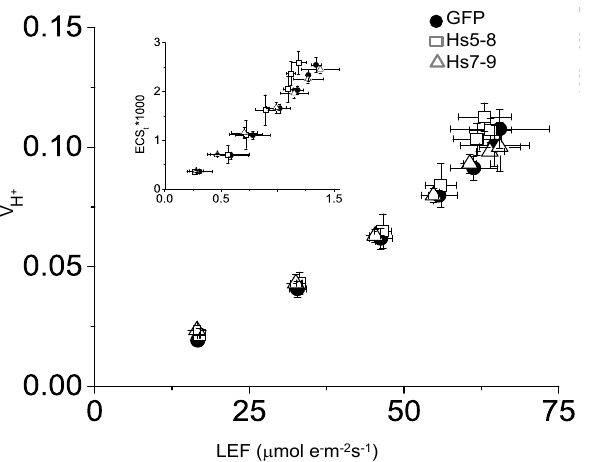
Figure 11. CEF is not increased in Hs PIPKIα plants. Light-driven transthylakoid proton flux ( v H+ ) as a function of linear electron flow (LEF) rates and relative light induced pmf , as measured by the total amplitude of the ECS decay (ECS ), as a function of pmf t attributable to LEF alone ( pmf ) (inset). GFP (circles), Hs 5-8 (open squares), and Hs 9-7 LEF (open triangles). Data represents mean and SD of individual leaves measured at